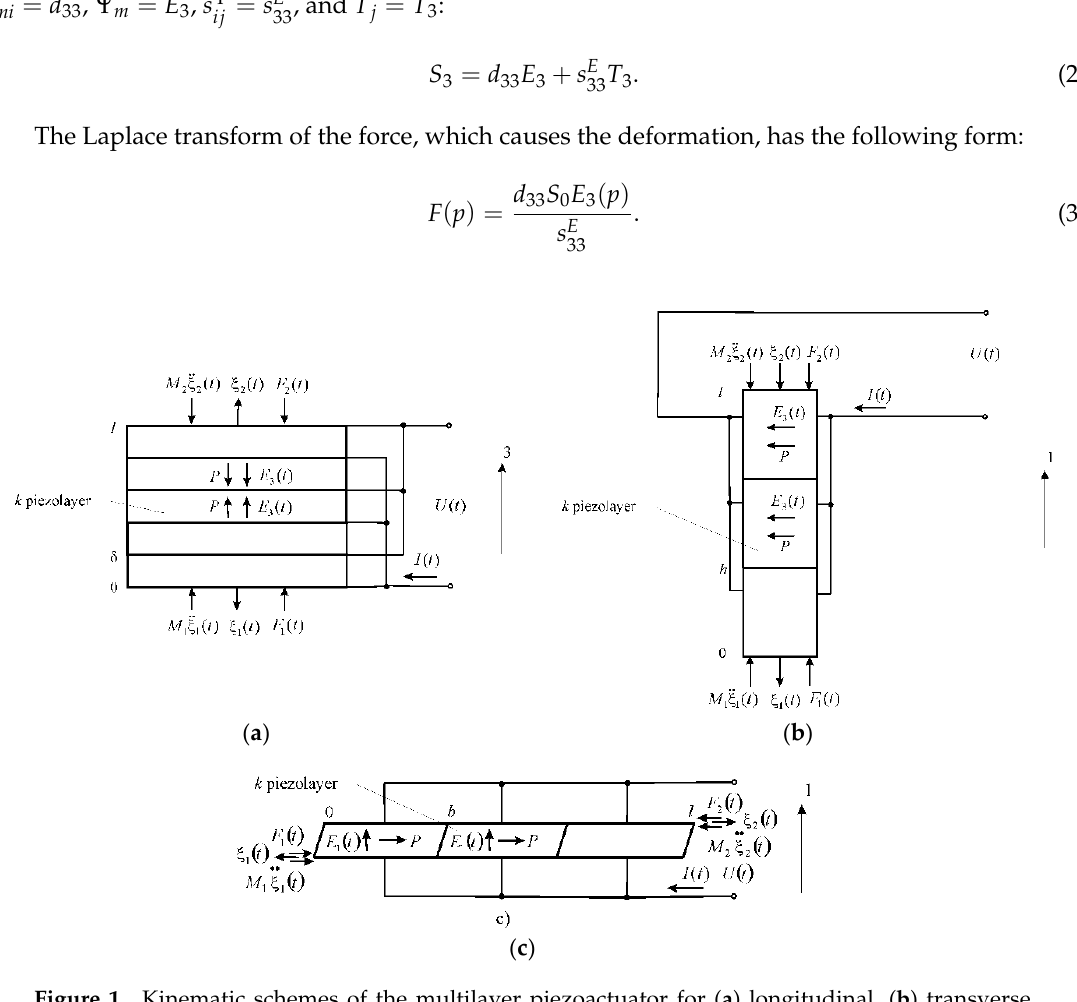
Figure 1. Kinematic schemes of the multilayer piezoactuator for ( a ) longitudinal, ( b ) transverse, and ( c ) shift piezoeffects, and the k piezolayer.